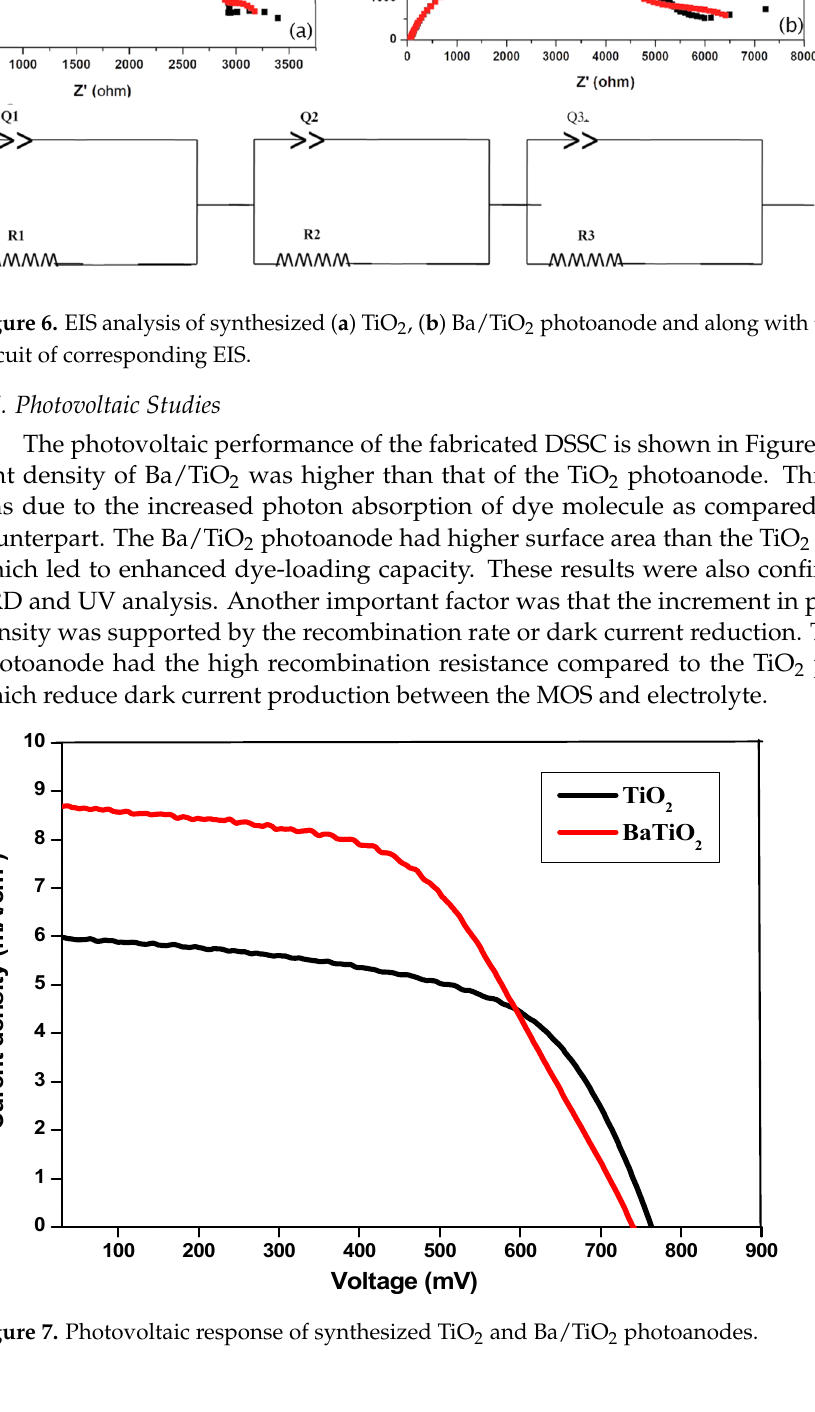
8 of 12 Figure 5. SEM analysis of synthesized ( a ) TiO 2 and ( b ) Ba/TiO 2 , and EDS analysis of synthesized ( c ) TiO 2 and ( d ) Ba/TiO 2 nanopowders. 3.4. Electrochemical Behavior of TiO 2 and Ba/TiO 2 The reaction kinetics linked with DSSCs were investigated using EIS results. EIS spectra of TiO 2 and Ba/TiO 2 photoanodes under dark conditions with 0.6 V open circuit voltage are depicted in Figure 6. The EIS of DSSC was explained by three semicircles in the high, middle, and low frequency range, corresponding to the electrochemical output in platinized counter-electrode and electrolyte-interface (R 1 ), WE/electrolyte (R 2 ), and dif- fusion resistance of electrolyte (R d ), respectively. The displacement of the graph from origin represents the series resistance due to the contact resistance of the cell (R s ) [55]. Associated charge transfer in the electrolyte influenced the low frequency region, which was evident from the third semicircle. From the fitted data, the Ba/TiO 2 photoanode